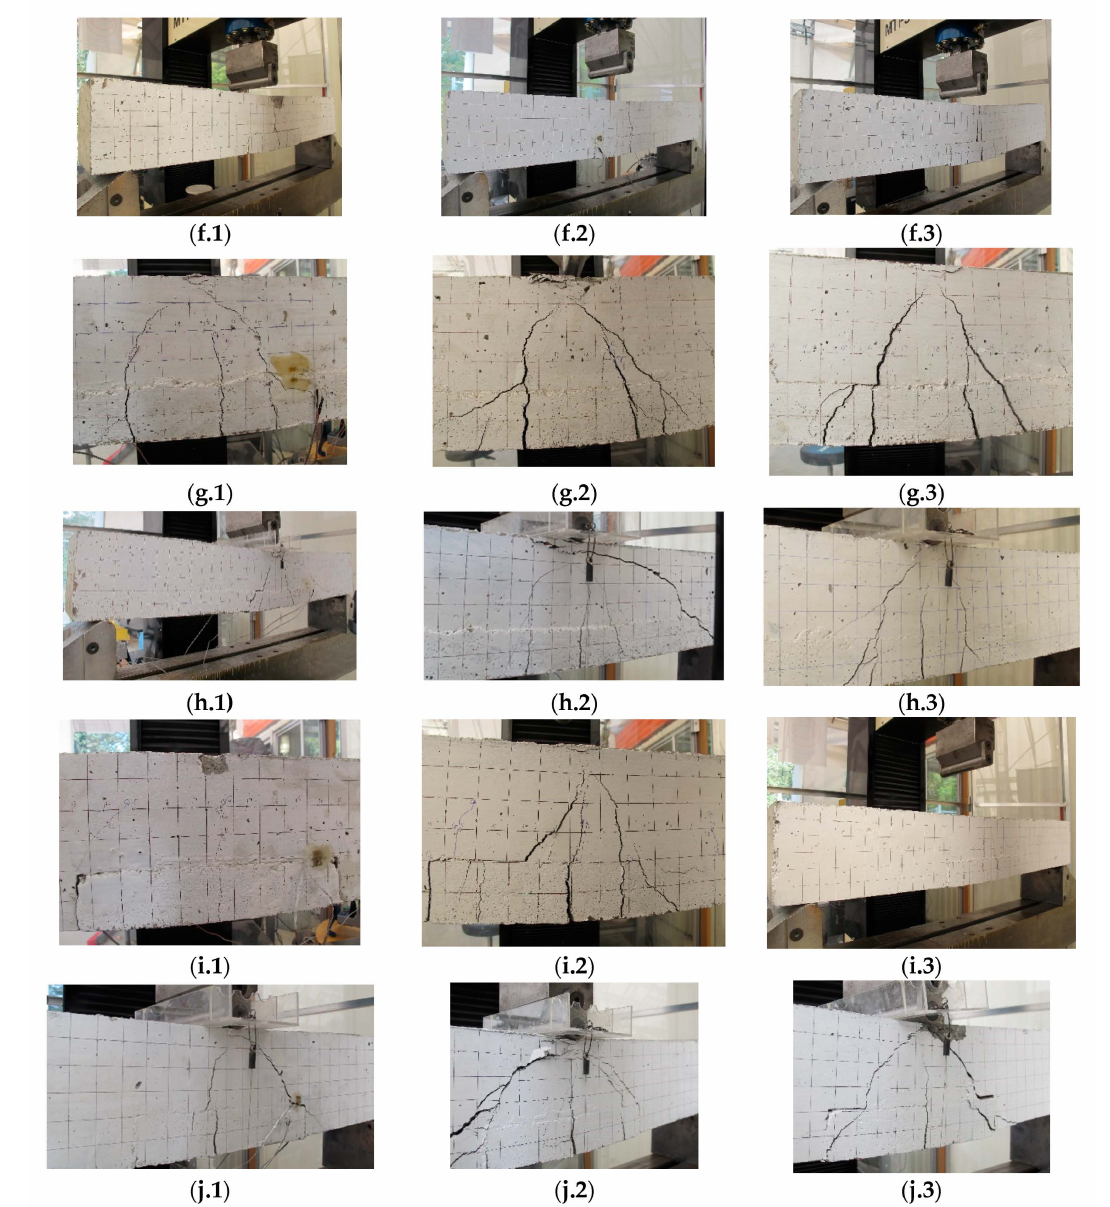
Figure A1. Failure Crack Patterns: ( a.1 – a.3 ) Control samples 1–3 under static load. ( b.1 , b.2 ) Control samples 1–2 under repeated load. ( c.1 – c.3 ) Mix F sample 1–3 repaired in full length under static load. ( d.1 , d.2 ) Mix F samples 1–2 repaired in full length under repeated load. ( e.1 – e.3 ) Mix F samples 1–3 repaired in 1/3 span under static load. ( f.1 – f.3 ) Mix F samples 1–3 repaired in 1/3 span under repeated load. ( g.1 – g.3 ) Mix M samples 1–3 repaired in full length under repeated load. ( h.1 – h.3 ) Mix M samples 1–3 repaired in full length under static load. ( i.1 – i.3 ) Mix M samples 1–3 repaired in 1/3 span under repeated load. ( j.1 – j.3 ) Mix M samples 1–3 repaired in 1/3 span under static